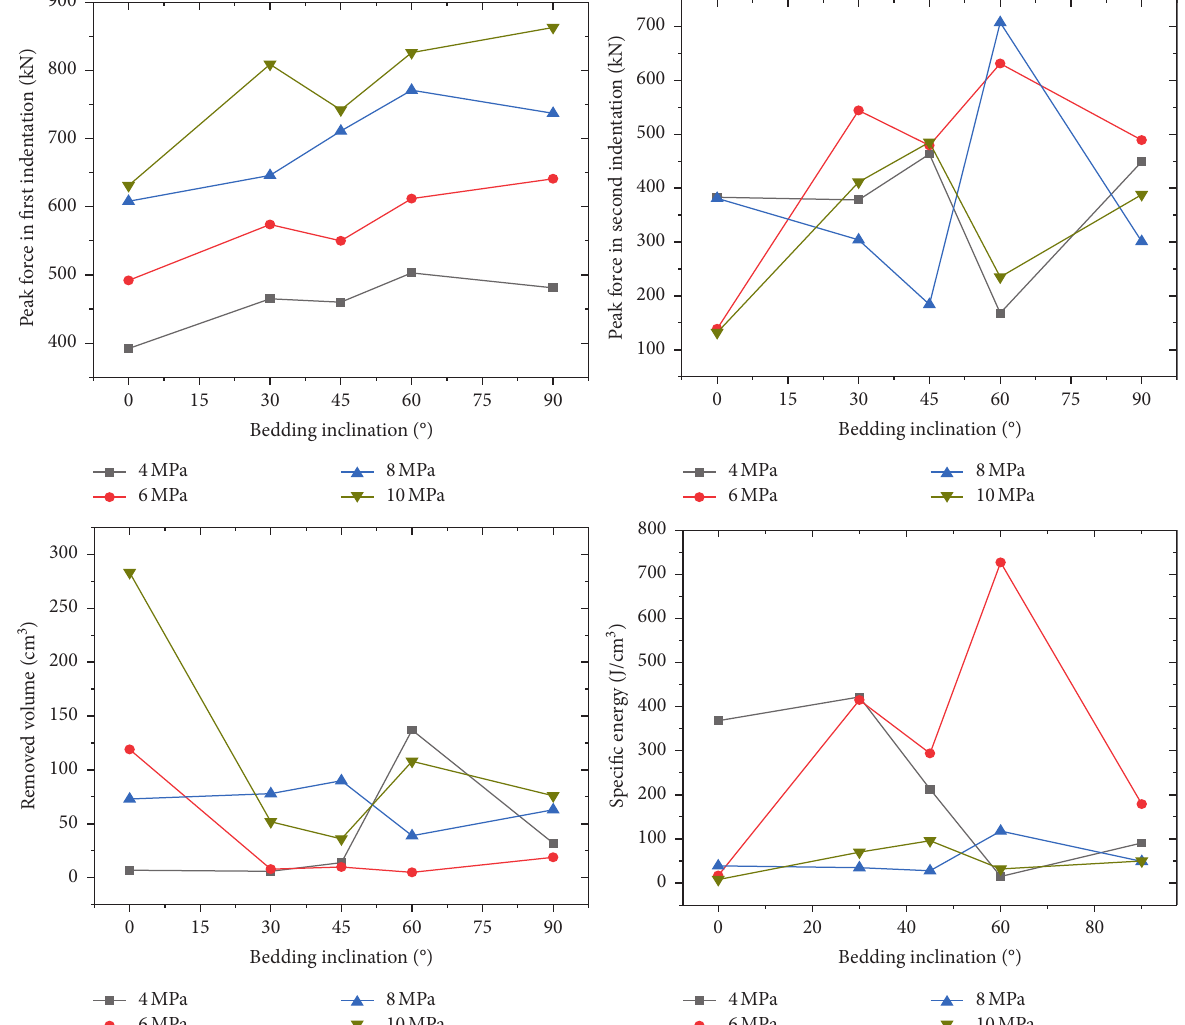
Figure 7: Effects of bedding inclination and confining stress on specific